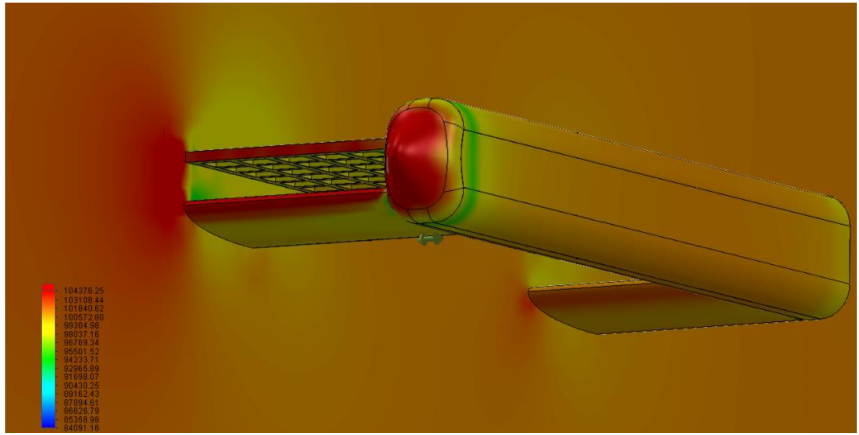
Figure 14. Pressure distribution in the test with the angle of attack equal to 10 ◦ and the velocity of the robot equal to 5 m/s. Isometric and cut plot from bottom